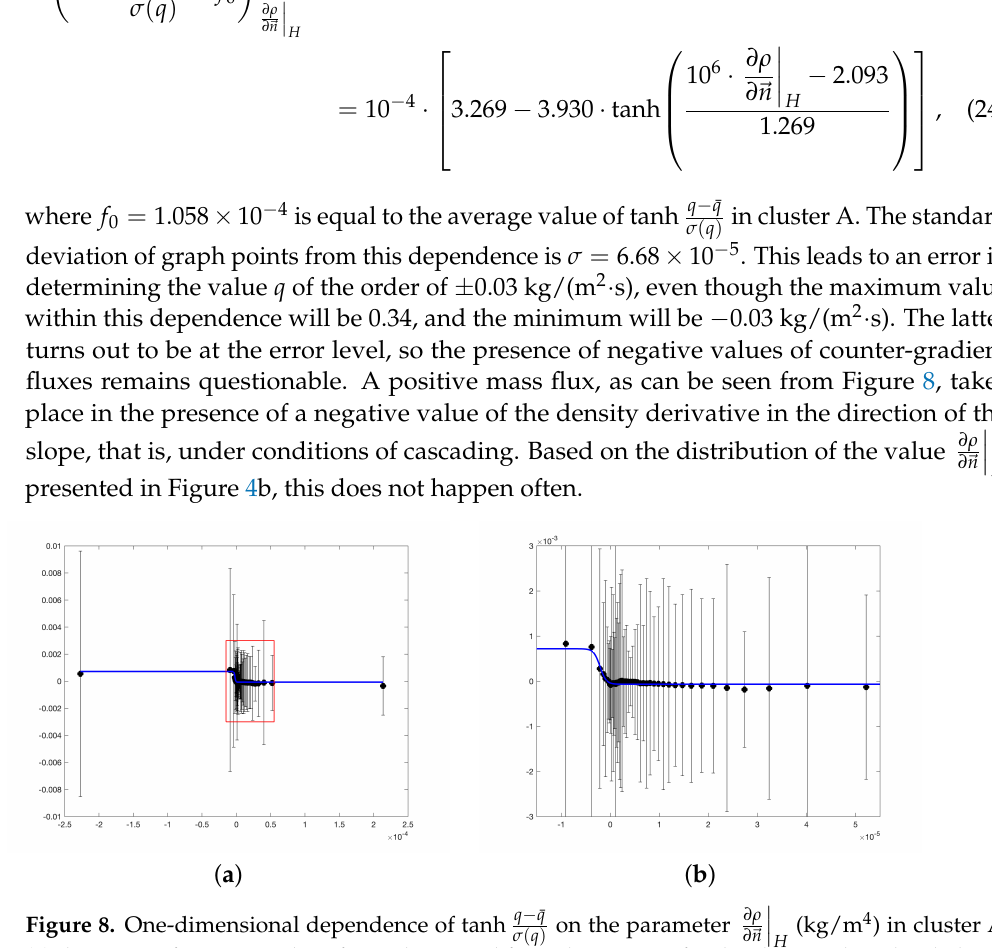
Figure 8. One-dimensional dependence of tanh q − ¯ q ( a ) deviation of average values for each interval from the average for the cluster when divided into 50 intervals with an equal number of cluster elements; ( b ) an enlarged view of the group of dots in a red box shown in ( a ). The blue curve represents the closest functional relationship. The vertical bars show the standard deviation for each